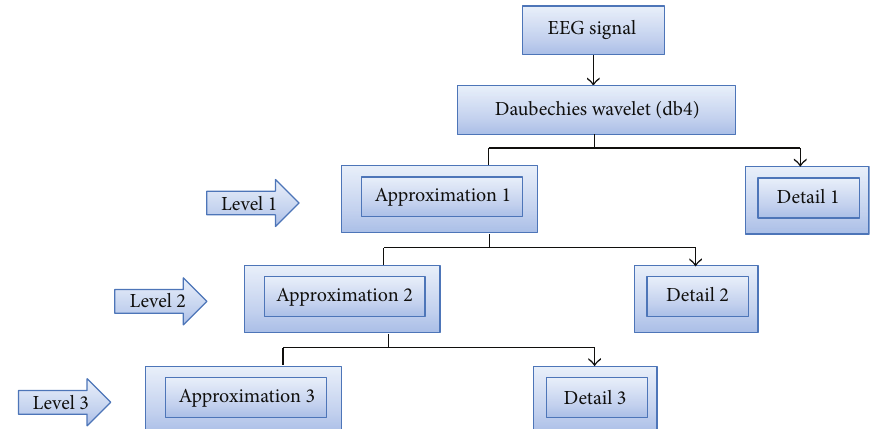
Figure 9: Wavelet multiresolution